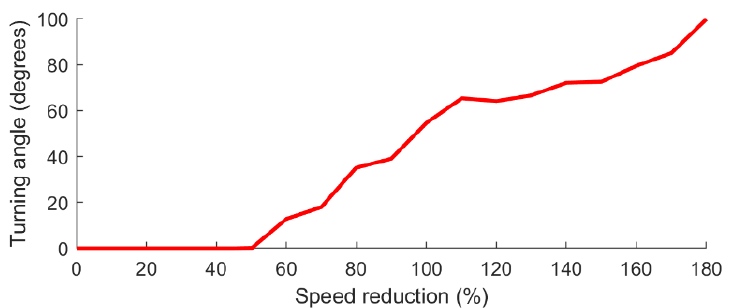
Figure 3. Speed reduction when negotiating a turn at various angles as measured in [25].